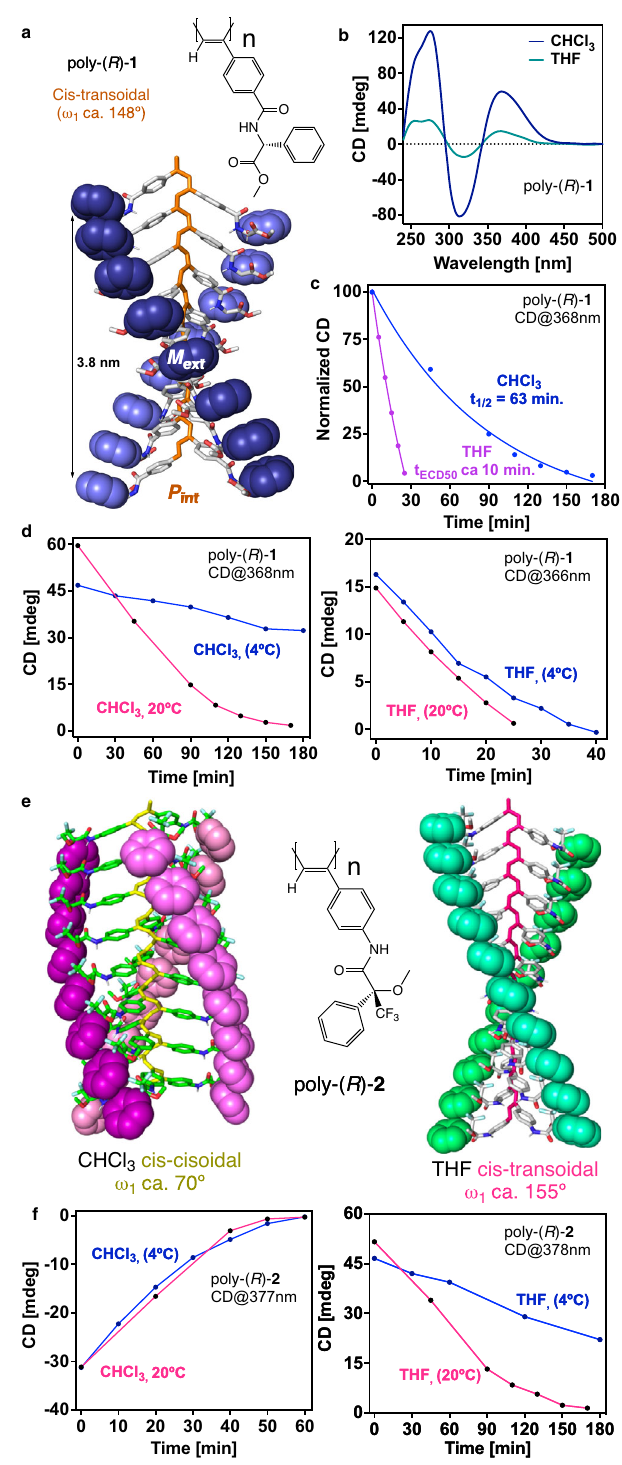
Fig. 2 | Structuresofpoly-( R )-1 and ofpoly-( R )-2 and ECD signaldecayvs.time. a Chemicaland3Dstructureofpoly-( R )- 1 58 . b ECDspectraofpoly-( R )- 1 inCHCl 3 and THF (blue and green lines, respectively). c Normalized CD signal decay vs. time for poly-( R )- 1 at different irradiation times under visible light in CHCl 3 and THF (pink andbluelines,respectively). d ECDsignaldecayvs.timeforpoly-( R )- 1 ,inCHCl 3 and THF, at different irradiation times under visible light at two temperatures (20°C pink line, 4°C blue line). e Chemical and 3D models of poly-( R )- 2 58 . f ECD signal decayvs.timeforpoly-( R )- 2 ,inCHCl 3 andTHF,atdifferentirradiationtimesunder visible light at two temperatures (20°C pink line, 4°C blue line). [poly-( R )- 1 ]= 1.02·10 -3 M, [poly-( R )- 2 ]= 9.00·10 − 4